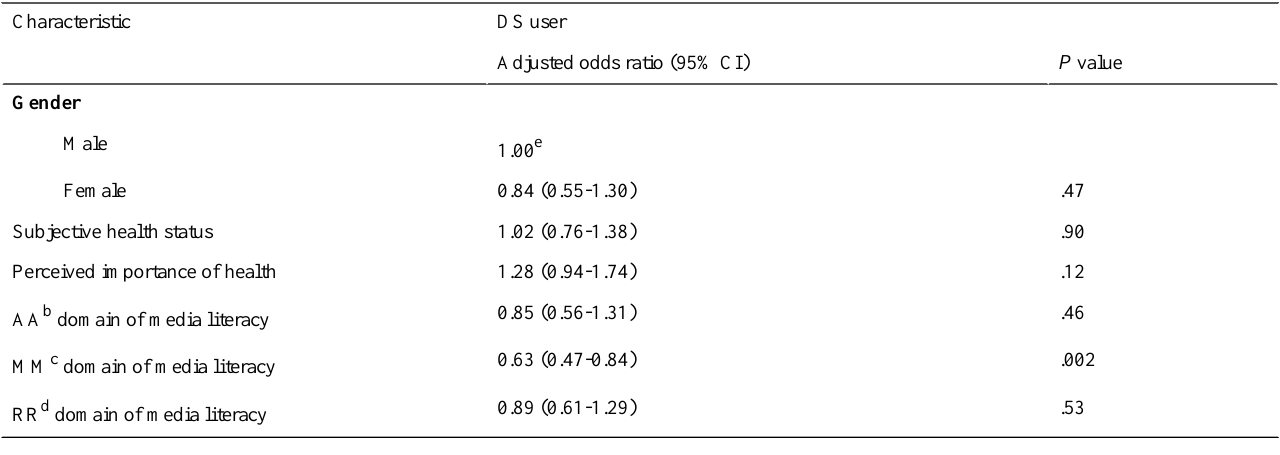
Table 4. Logistic regression analysis of DS a use.